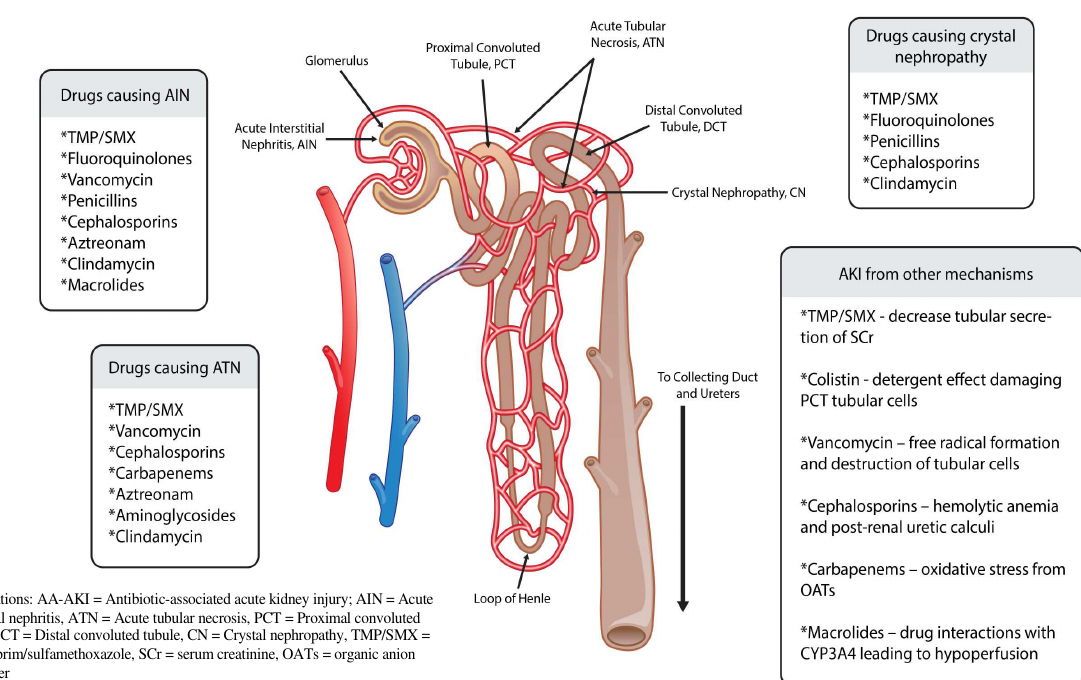
Figure 1. Antibiotics causing AA-AKI and mechanism with nephron.